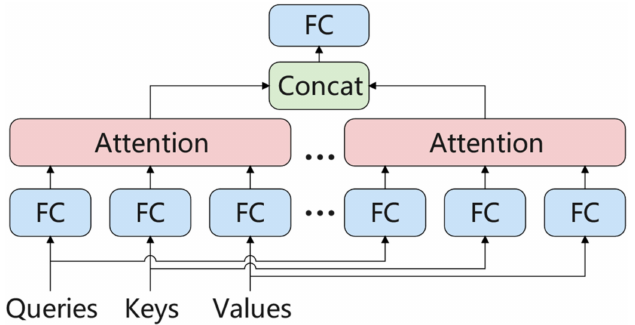
Figure 2. The multihead self-attention